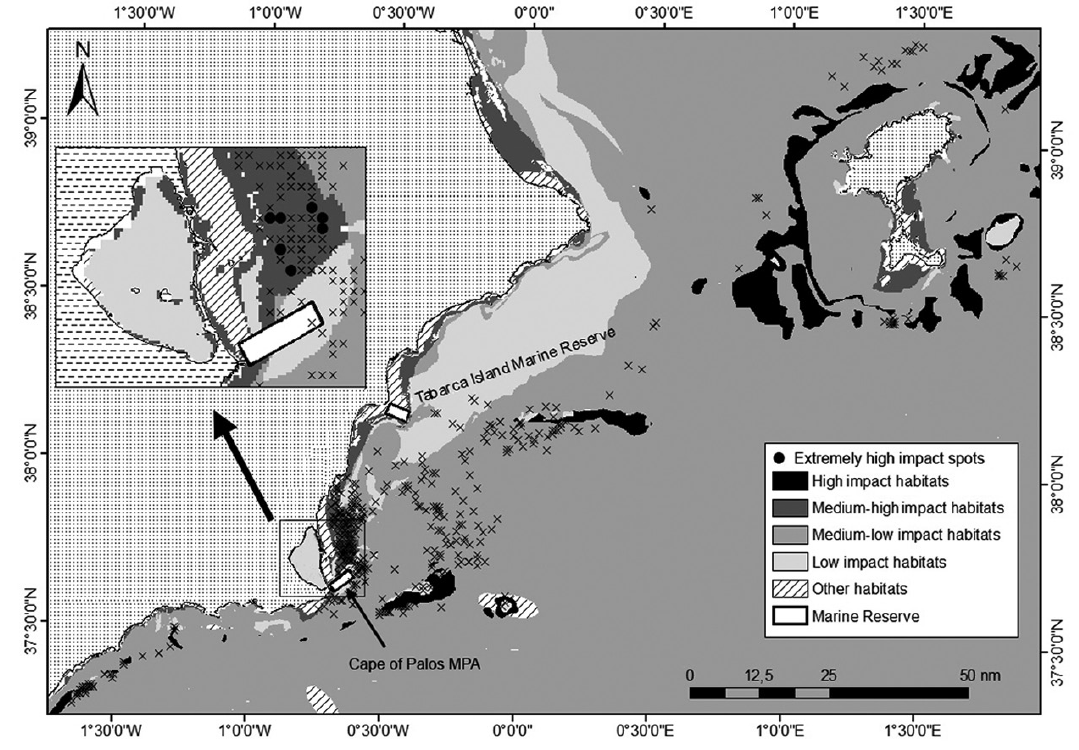
Fig. 3. – Impact level predicted according to the distance from the Cape Palos marine reserve, depth and type of